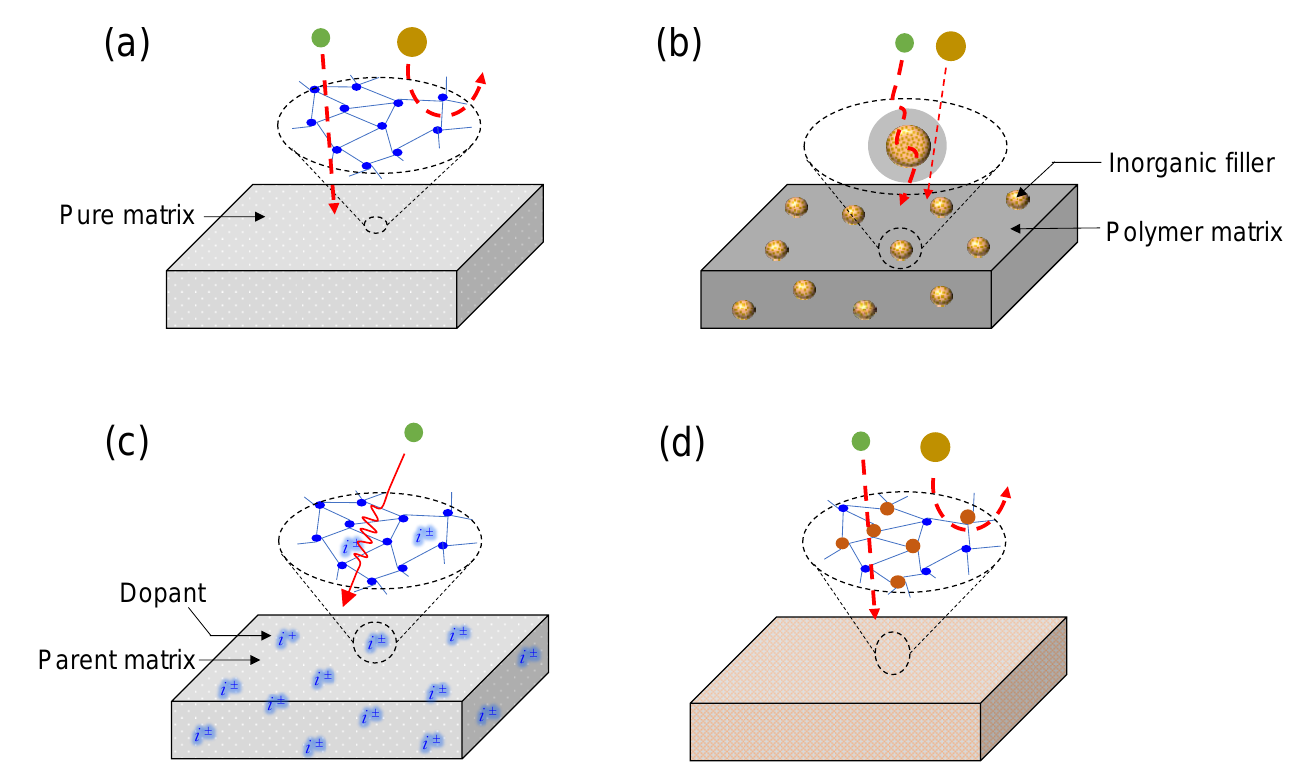
Figure 2. Illustration of the categorization of membranes by matrix composition: ( a ) single-matrix membranes; ( b ) mixed-matrix membranes; ( c ) doped matrix membranes; ( d ) composite matrix membranes.